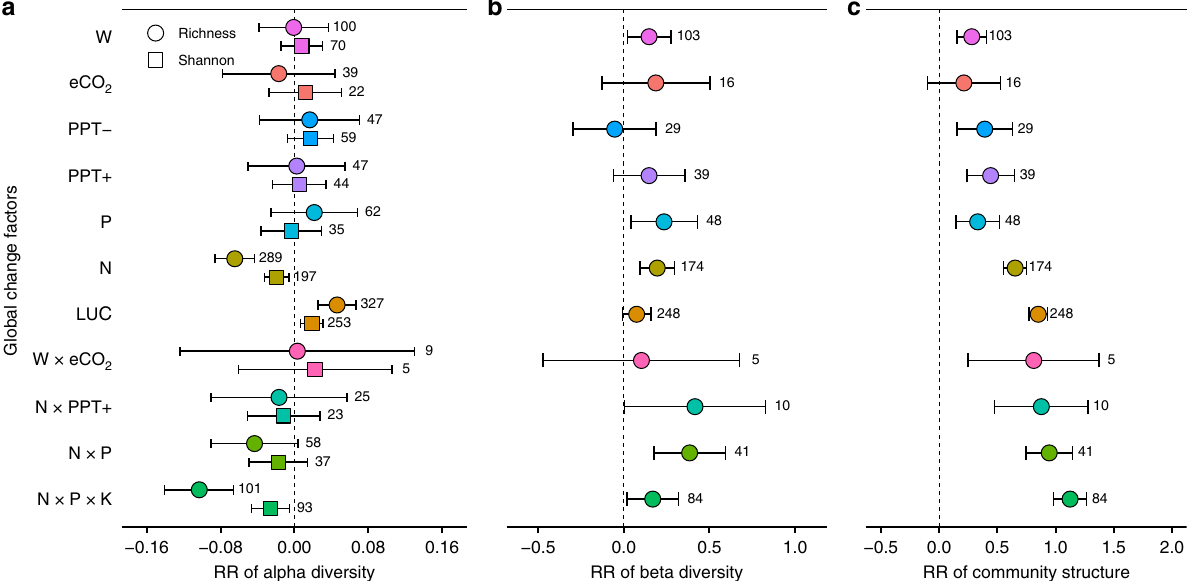
Fig. 1 Responses of microbial diversity and community structure. a Response ratio (natural logarithm-transformed ratio of treatment to control, RR) of microbial alpha diversity (richness and Shannon index). b RR of microbial beta diversity. c RR of microbial community structure. Weighted means and their 95% con fi dence intervals of RRs are given. The numbers at the right side of the con fi dence intervals represent the sample sizes. W warming, eCO 2 carbon- dioxide enrichment, PPT − decreased precipitation, PPT + increased precipitation, P phosphorous addition, N nitrogen addition, LUC land-use change, W × eCO 2 warming plus carbon-dioxide enrichment, N × PPT + nitrogen addition plus increased precipitation, N × P nitrogen plus phosphorous addition, N × P × K nitrogen plus phosphorous plus potassium addition. Source data are provided as a Source Data fi